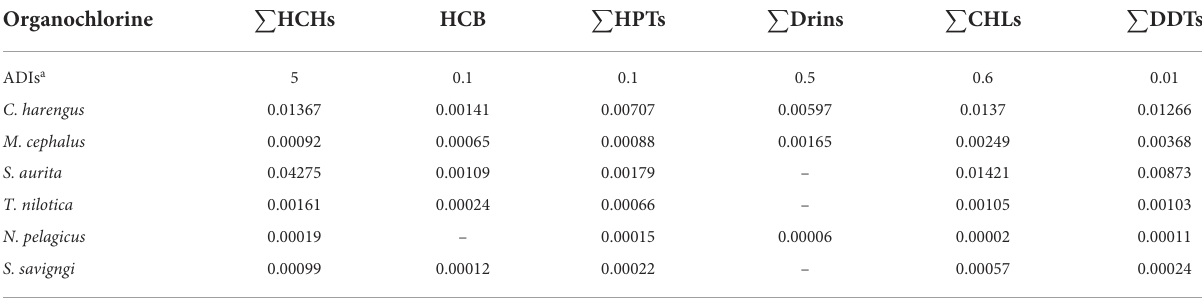
TABLE 4 Estimated daily intake (EDI µ g/kg /day) of Organochlorine pesticides for Mansoura citizens, Egypt, due to seafood consumption in comparison to recommended acceptable daily intake (ADIs µ g/kg /day).